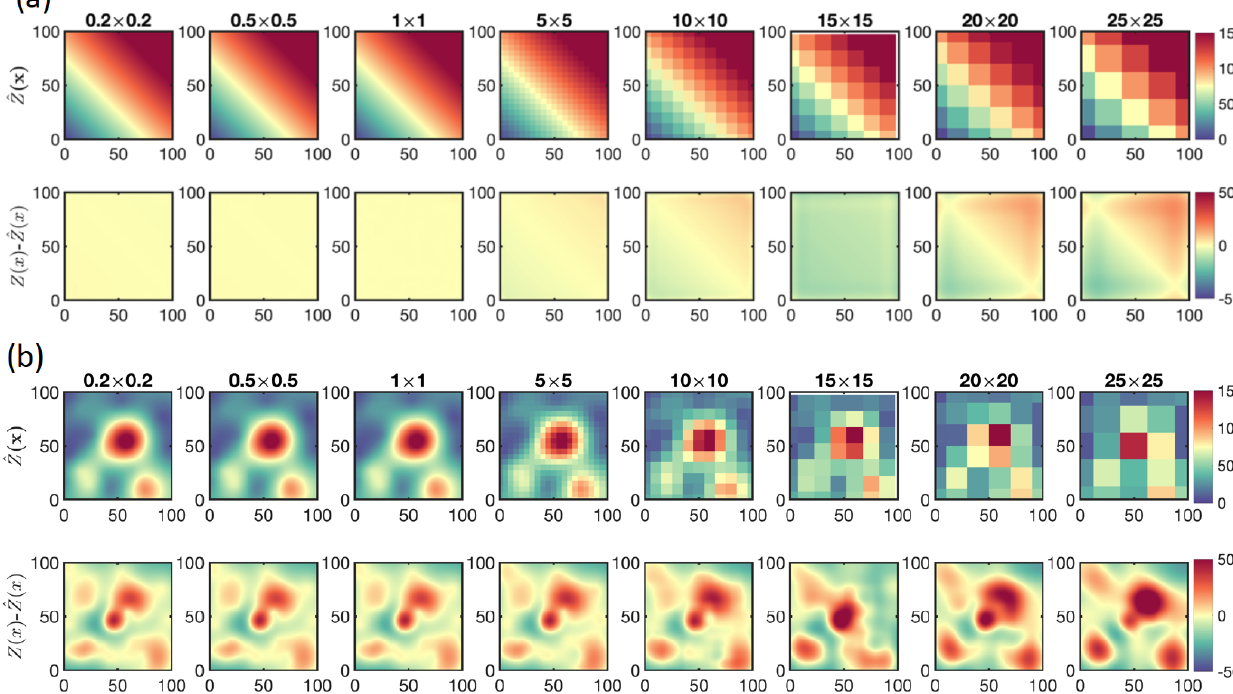
Figure 5. Finding an optimum grid size for kriging. (a) The kriging estimates of the ramp (C2) at different grid resolutions ranging from 25 × 25 pixel to 0 . 2 × 0 . 2. (b) The kriging estimates of the multi-plume (C5) with optimized samples shown in Fig. 3 for different grid resolutions. C2 is more homogeneous than C5; as a result, it is less sensitive to the resolution of the kriging estimate. The optimum grid resolution for C2 is 10 × 10, whereas it is 1 × 1 for C5. These numbers are based on observing the negligible difference ( < 1%) between the kriging estimate at the optimum resolution and the one computed at a finer-resolution step. We call the optimum output for C5 as